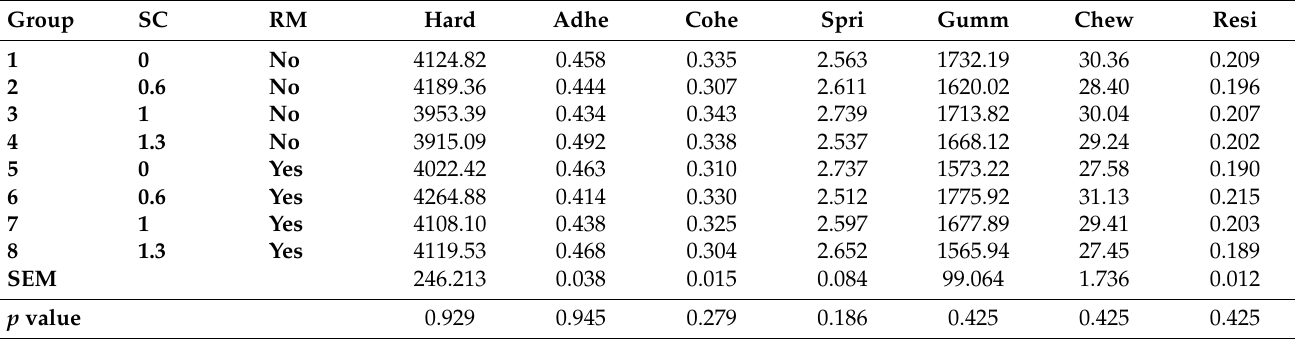
Table 7. Yeasts supplemented broilers’ thigh meat texture